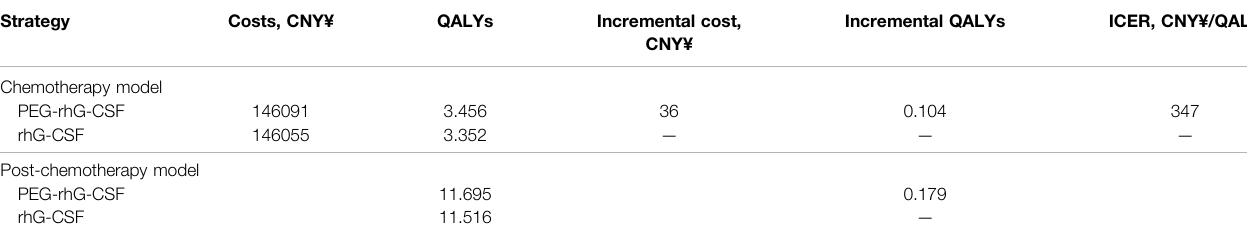
TABLE 3 | Cost-effectiveness analysis results. Strategy